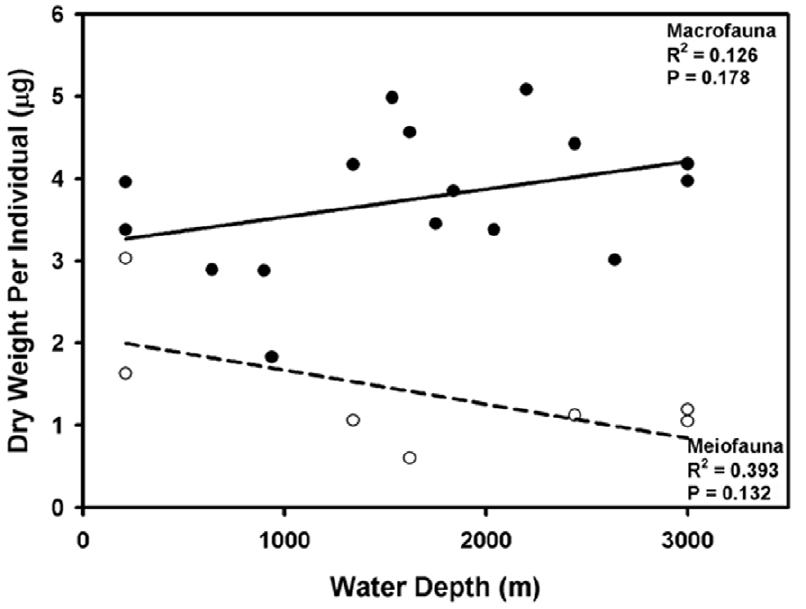
doi:10.1371/journal.pone.0014491.g002